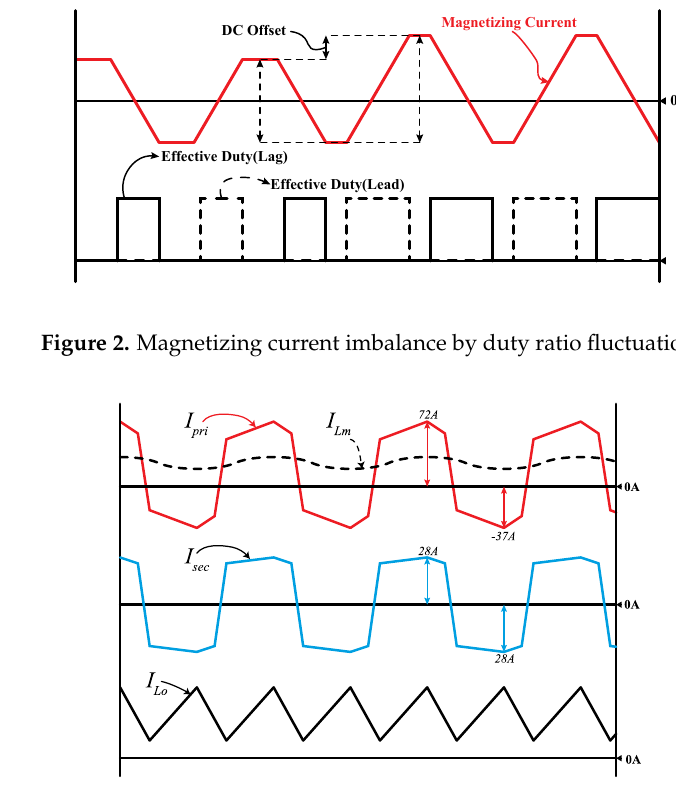
Figure 3. Current waveforms under the magnetization current